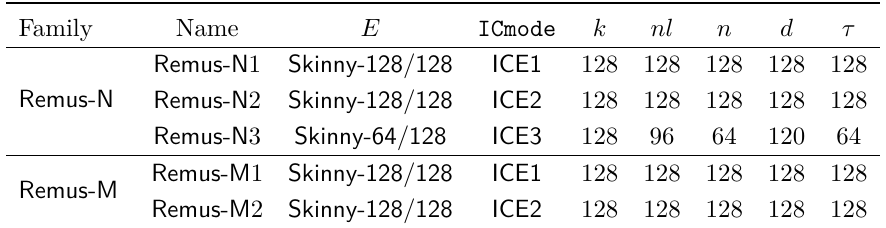
Table 7: Members of Remus